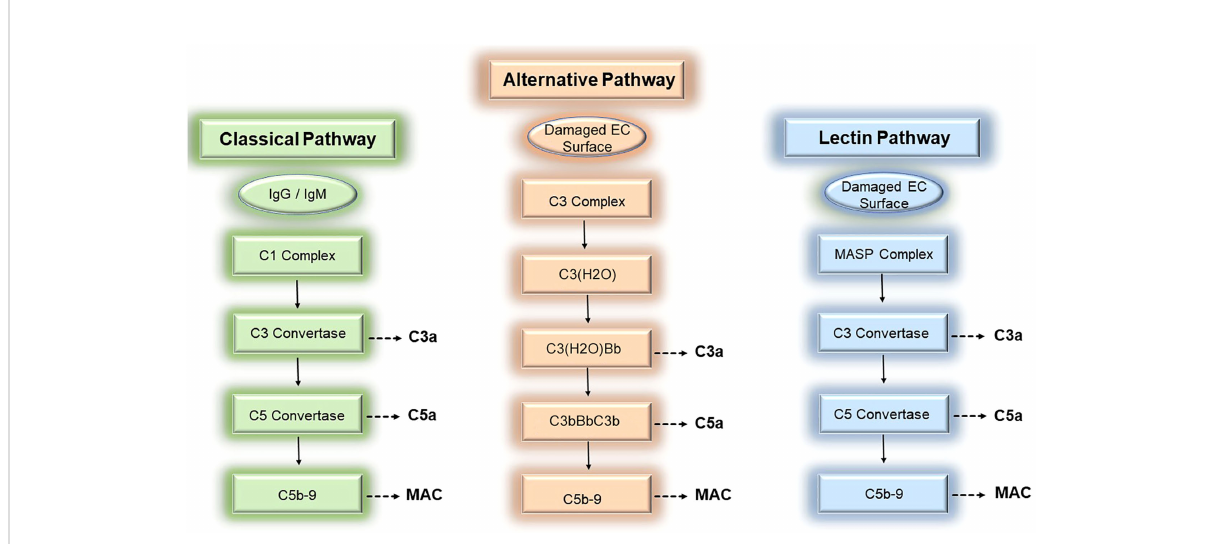
FIGURE 1 Three pathways of complement activation. The complement cascade may be activated by donor endothelial cells via 3 separable pathways, the classical (left), alternative (middle), and lectin (right) pathways, to mediate rejection of tissue